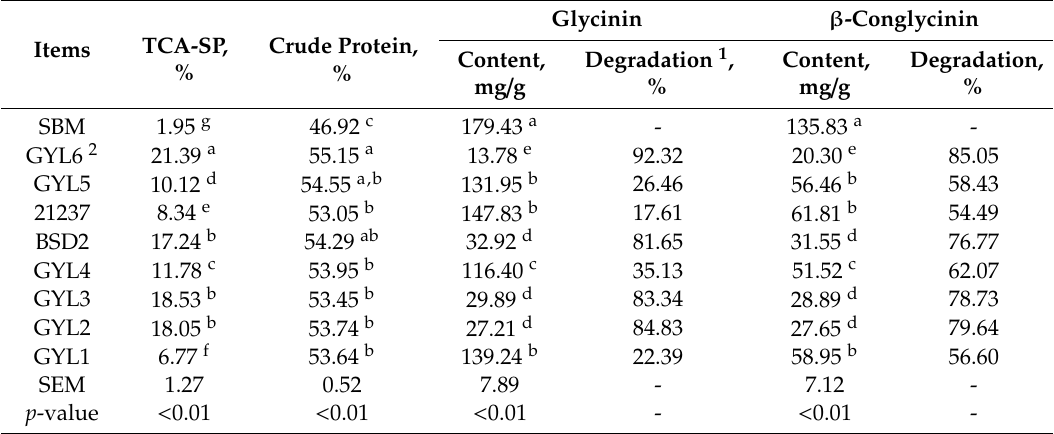
Table 2. E ff ects of fermentation with di ff erent candidate strains on the contents of TCA-SP, antigenic protein, and crude protein in SBM.